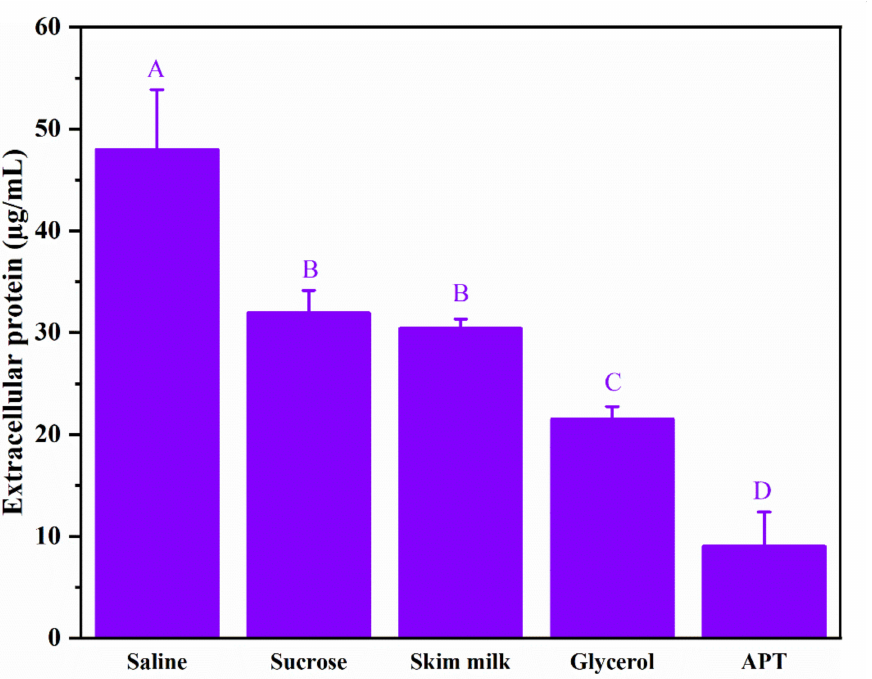
Figure 5. Effects of saline, positive cryoprotectants, and APT on the proteins leakage of L. rhamnosus after frozen at − 20 ◦ C for 24 h. The bars with different lowercase letters indicate significant differences ( p < 0.05).